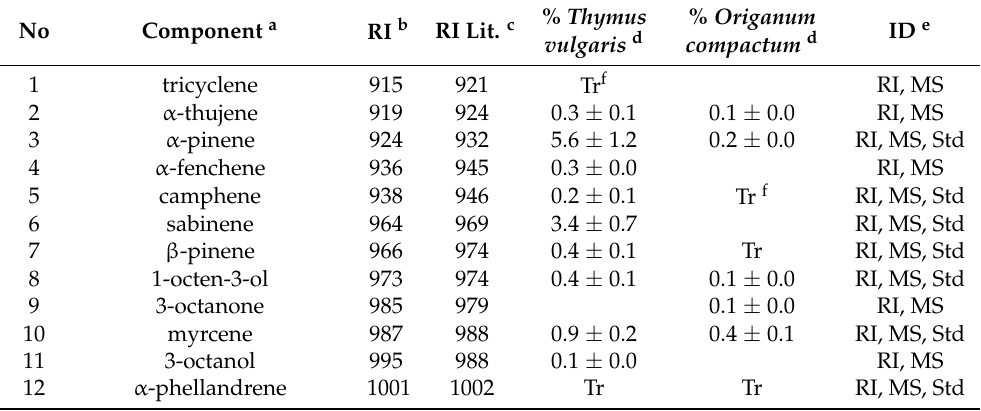
Table 1. Chemical composition of the essential oils from Thymus vulgaris and Origanum compactum